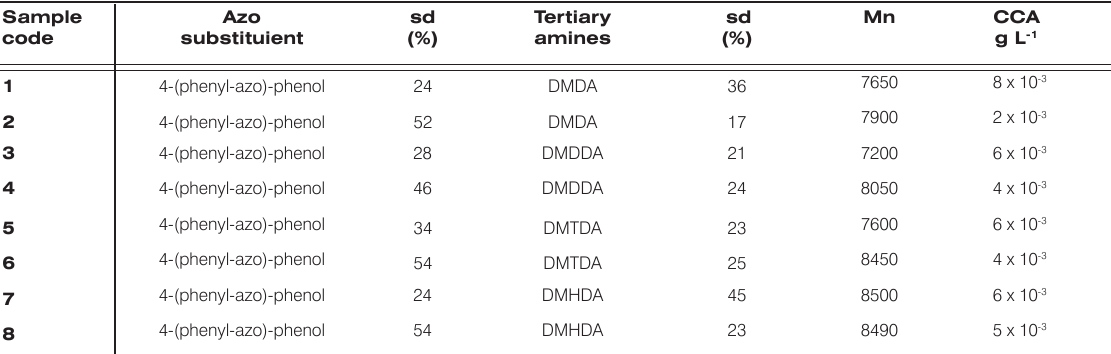
Table 1. Characteristics of different azo-polysiloxanes. Sample